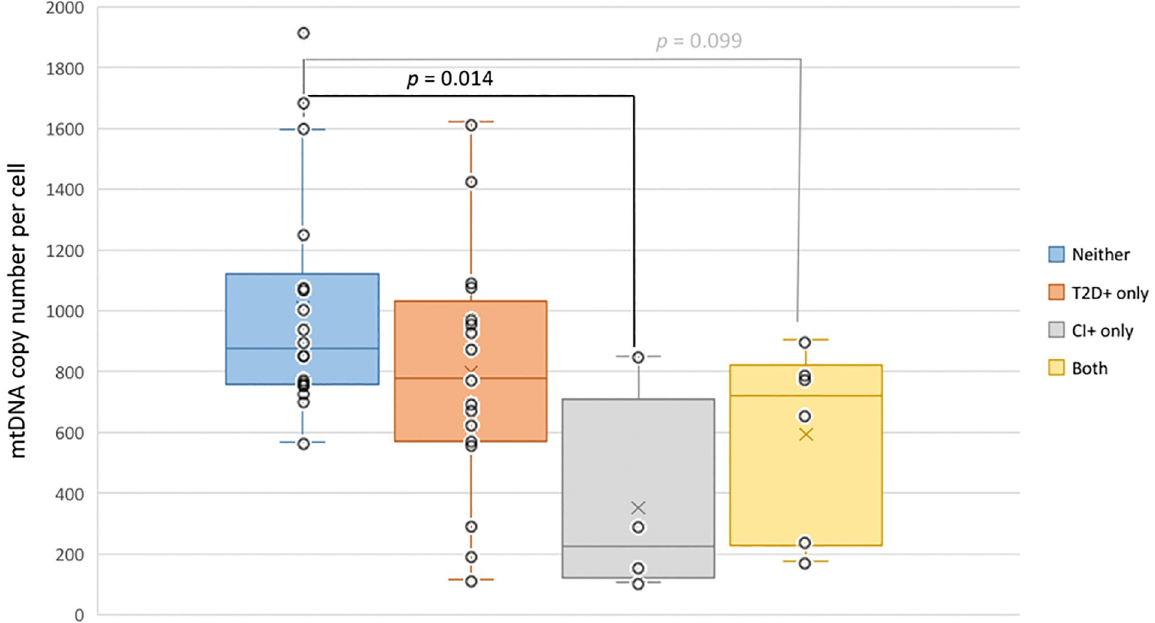
Fig 5. Average mitochondrial DNA copy number stratified by condition. Copy number of mitochondrial genomes is significantly lower in cognitively impaired individuals when compared to controls (ANOVA p-value = 0.009, with significant Tukey post-hoc p-value = 0.014 as shown; Kruskal-Wallis Test p-value = 0.027; respective Shapiro-Wilk p-values = 0.006, 0.880, 0.131, 0.151).